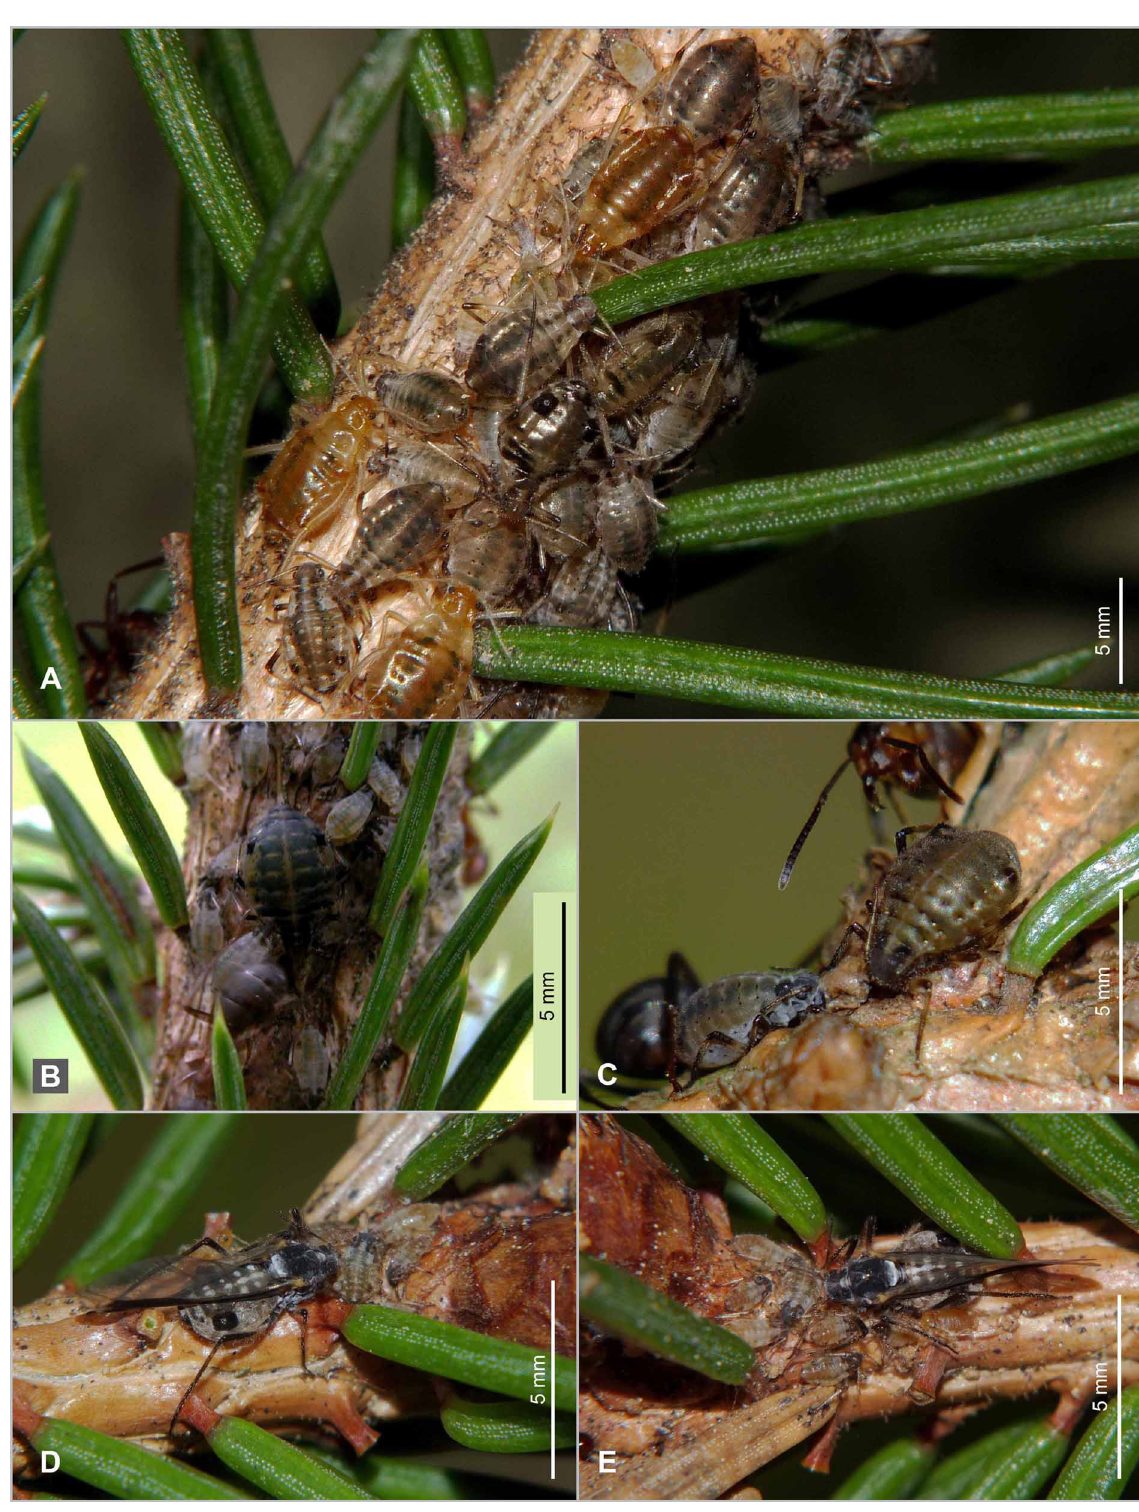
Fig. 37. Cinara (Cinara) pruinosa (Hartig, 1841) on Picea abies . A . Adult and juvenile apterae, including teneral adults. B . Fundatrix with juvenile apterae. C . Juvenile and adult fundatrix, attended by Formica aquilonia Yarrow, 1955. D–E . Alatae with newly founded